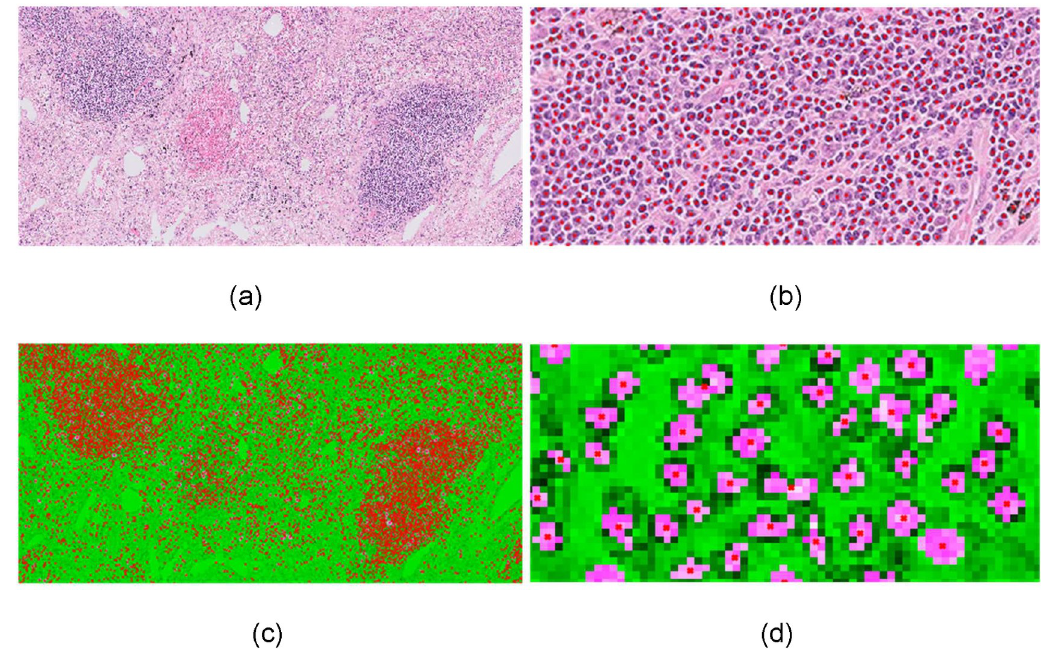
Fig 2. Lymphocyte segmentation. (a) input 10x H&E-stained image, (b) lymphocytes identification -red dots, (c) separation of merged or overlapped cells through the proposed ellipsoidal modelling, (d) detailed image of single-cell segmentation.